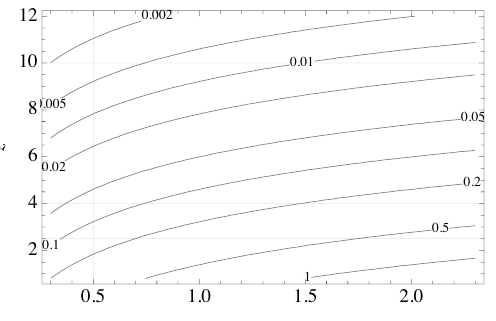
Figure 4. Contours of constant ν exp [ − z /2 ] , with z the height in units of the chromospheric scale height H , corresponding approximately to the values of dimensionless horizontal wavenumber κ = k x H (as labelled) for which this z is the upper turning point of the fast